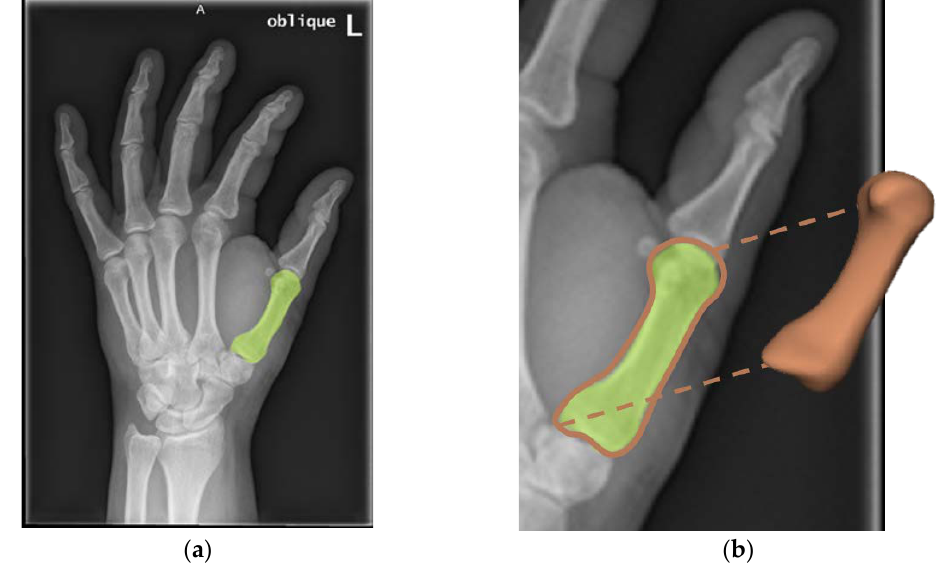
Figure 1. 3D model reconstruction pipeline: ( a ) original X-ray with automatically segmented 2D thumb metacarpal bone (green overlay); ( b ) 3D reconstructed shape (orange) generated by fitting the shape model projection (orange contour) to the 2D segmentation.